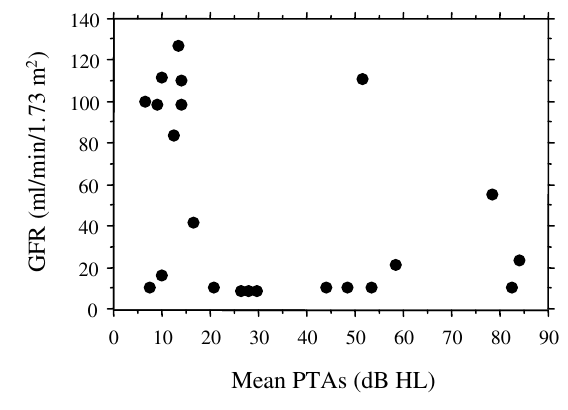
Figure 3 Percentage of study subjects with pure-tone thresholds above the 95 th percentile for the 0.5, 1, 2, 4 frequencies and PTAs, and above the 90 th percentile for the 8 kHz frequency